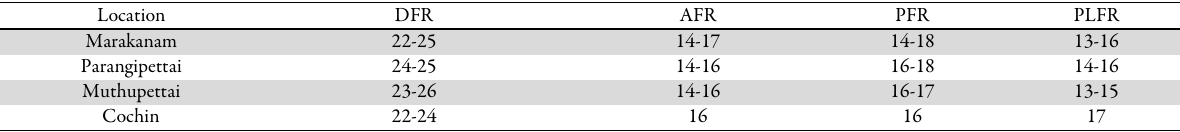
Table 2. Meristic characters in four populations of E. machnata